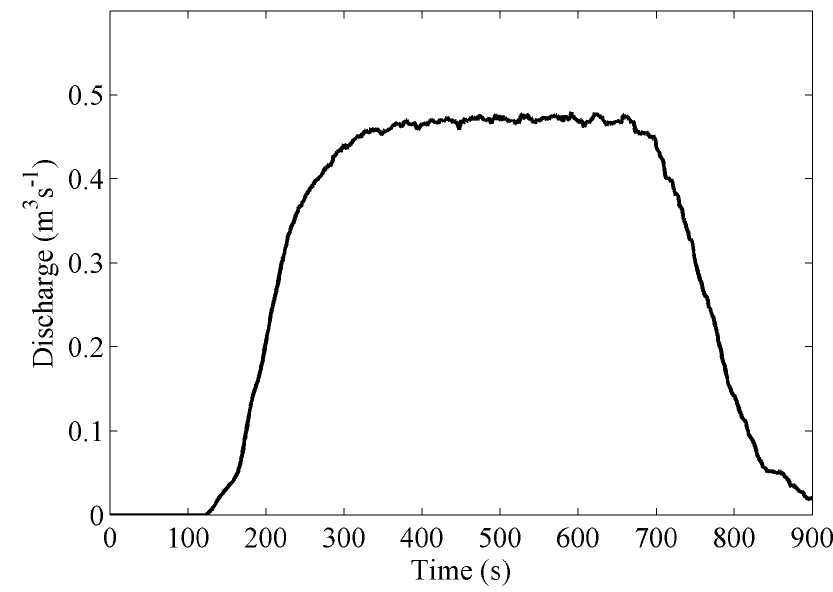
Figure 8. Water flow onto the road.